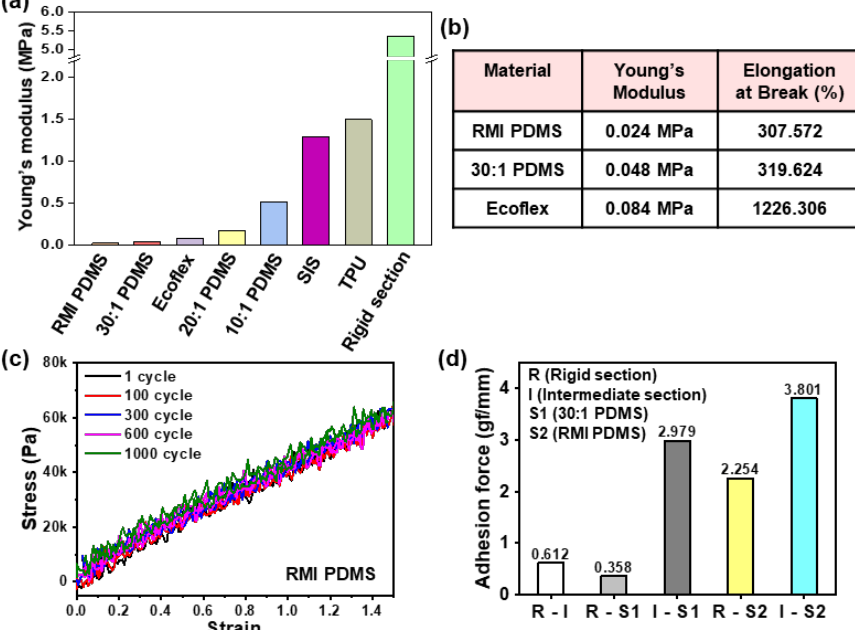
Figure 4. ( a ) Young’s modulus of various materials for the soft section. ( b ) Young’s modulus and elongation at the break of reverse-micelle-induced (RMI) polydimethylsiloxane (PDMS), 30:1 PDMS, and Ecoflex. ( c ) The stress–strain curves of RMI PDMS during 150% stretching over 1000 cycles. ( d ) Adhesion force of the soft sections (RMI PDMS and PDMS 30:1) with the rigid section and the intermediate section.